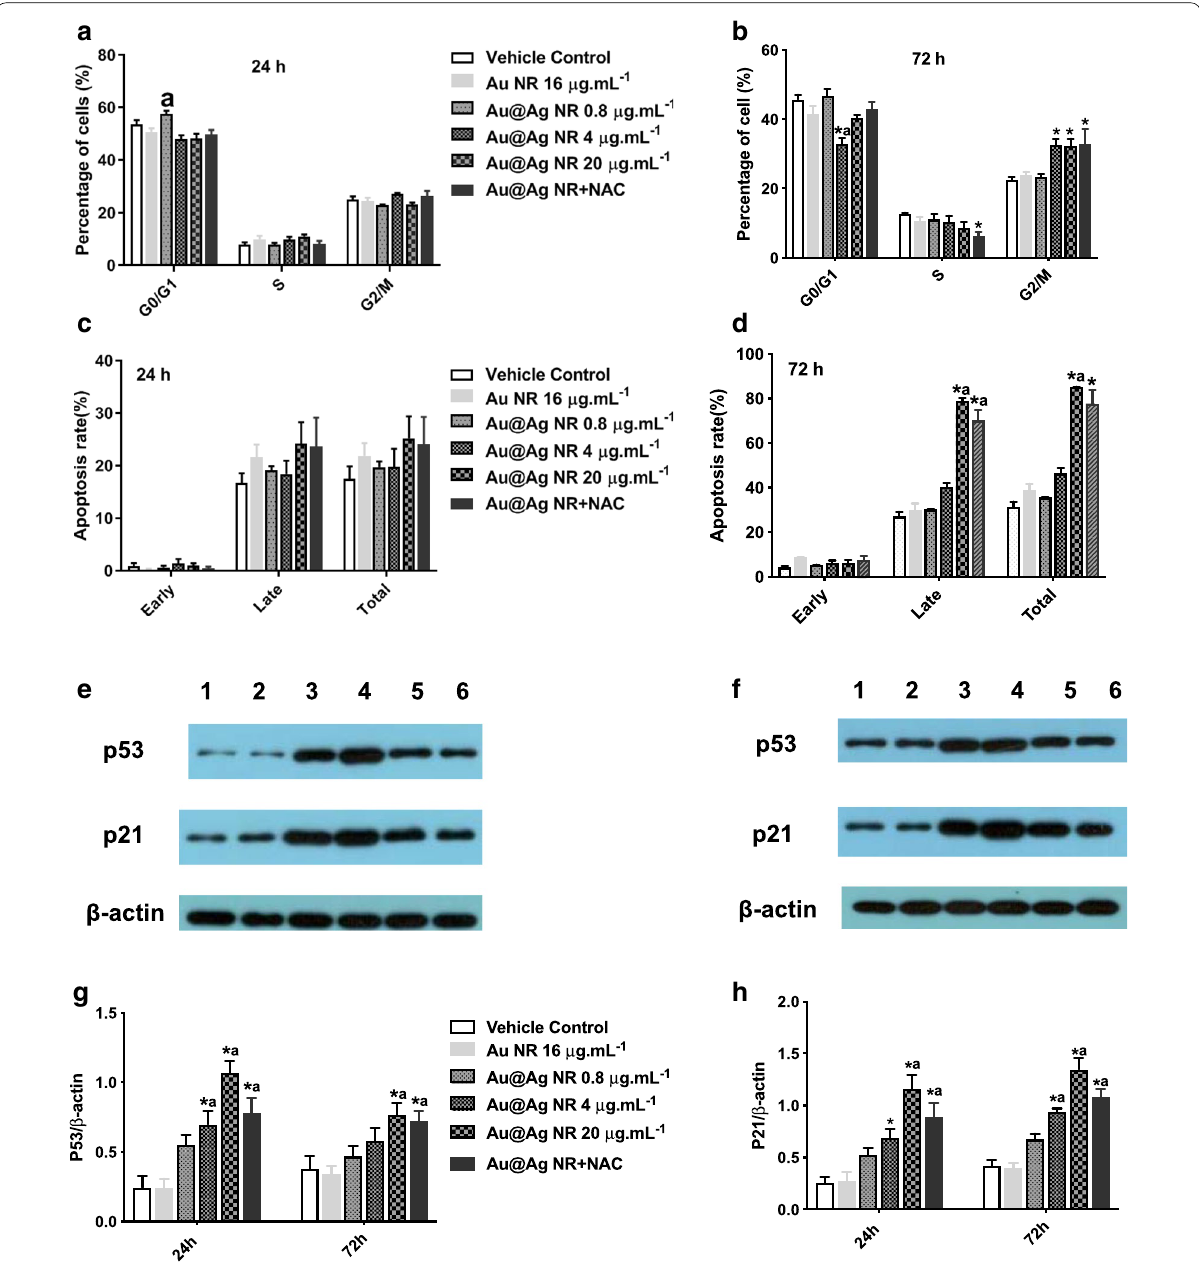
Fig. 6 Effects of Au@Ag NR on the cell cycle and apoptosis. Effects of Au@Ag NR on cell cycle ( a , b ) and apoptosis ( c , d ) after exposed for 24 h and 72 h, respectively; the representative data of expression levels of p53 and p21 in HepaRG cells of different groups ( e , f Lane 1: vehicle control; Lane 2: Au NR; Lane 3: Au@Ag NR NAC; Lane 4: Au@Ag NR 20 μg mL − 1 ; Lane 5: Au@Ag NR 4 μg mL − 1 ; Lane 6:Au@Ag NR 0.8 μg mL − 1 ); the averaged + relative expression level of p53 and p21 to β-actin in different groups was summarized in ( g , f ). * P < 0.05 versus vehicle control; a P < 0.05 versus Au